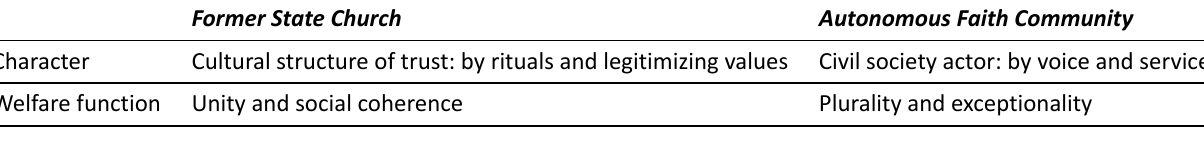
Table 1. Double roles of the Church of